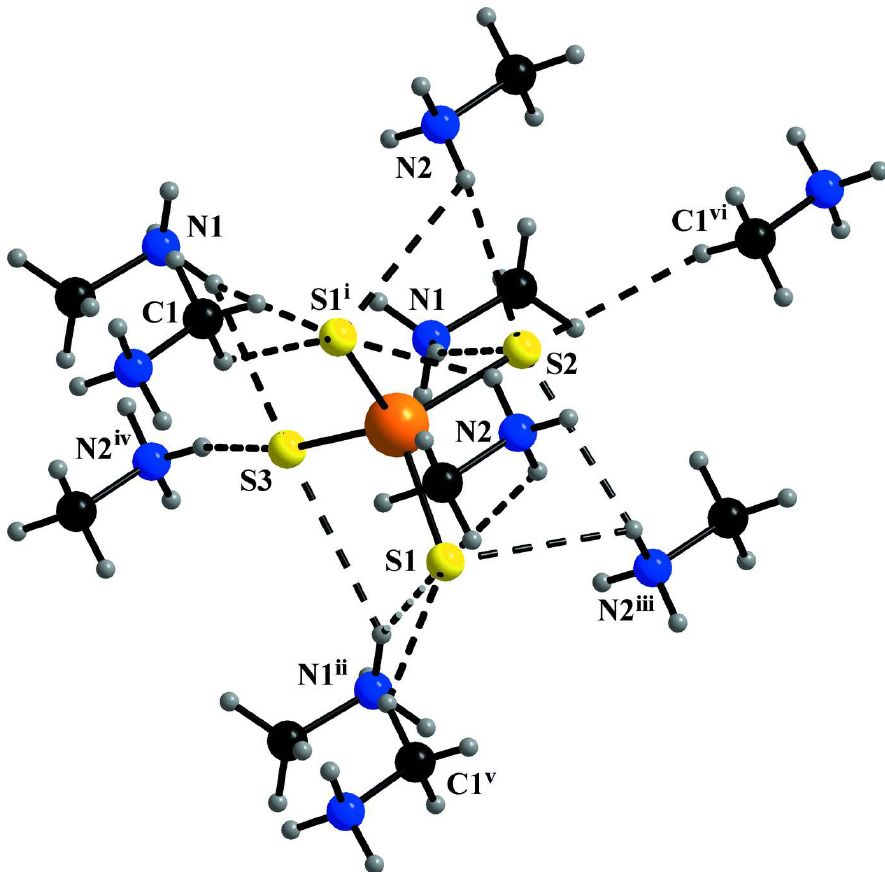
] 2- anion showing its linking to ten different organic cations with the aid of N— A view of the surroundings of the [WS 4 H···S and C—H···S interactions. Symmetry codes: (i) x , - y + 1/2, Z (ii) - x , - y , - z + 1; (iii) - x + 1, - y , - z + 1 (iv) x + 1, y , z (v) - x + 1/2, - y , z - 1/2 (vi) x - 1/2, - y + 1/2, - z +